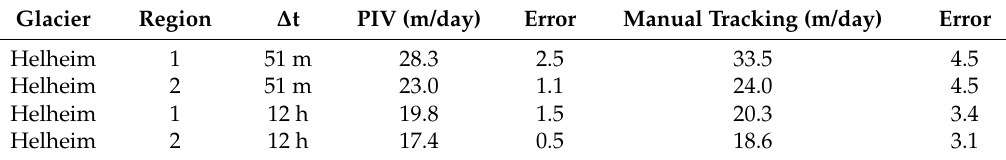
Figure 8. Region 1 results on the left and Region 2 results on the right, both for a time interval of 12 hours. The Helheim Glacier PIV results have been plotted on top of a contour plot of point density, rather than roughness. It is important to note that point density is scaled differently for Regions 1 and 2, in order to highlight the attributes of each. Raw PIV results were averaged at a resolution of 100 m × 100 m. Though not shown, average surface roughnesses for Regions 1 and 2 were 0.8 m and 1.0 m respectively. Table 2. PIV and manual tracking results for Helheim Glacier.